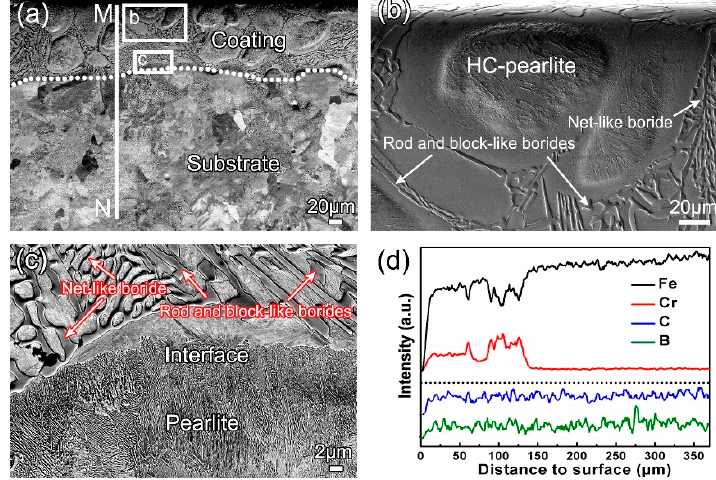
Figure 3. Sectional microstructure of the BCr-15 sample: ( a ) BSEI image of the coating; ( b ) ( c ) high magnification SEI and BSEI images corresponding to the white boxes in ( a ); ( d ) EDS line scanning in ( a ) (M to